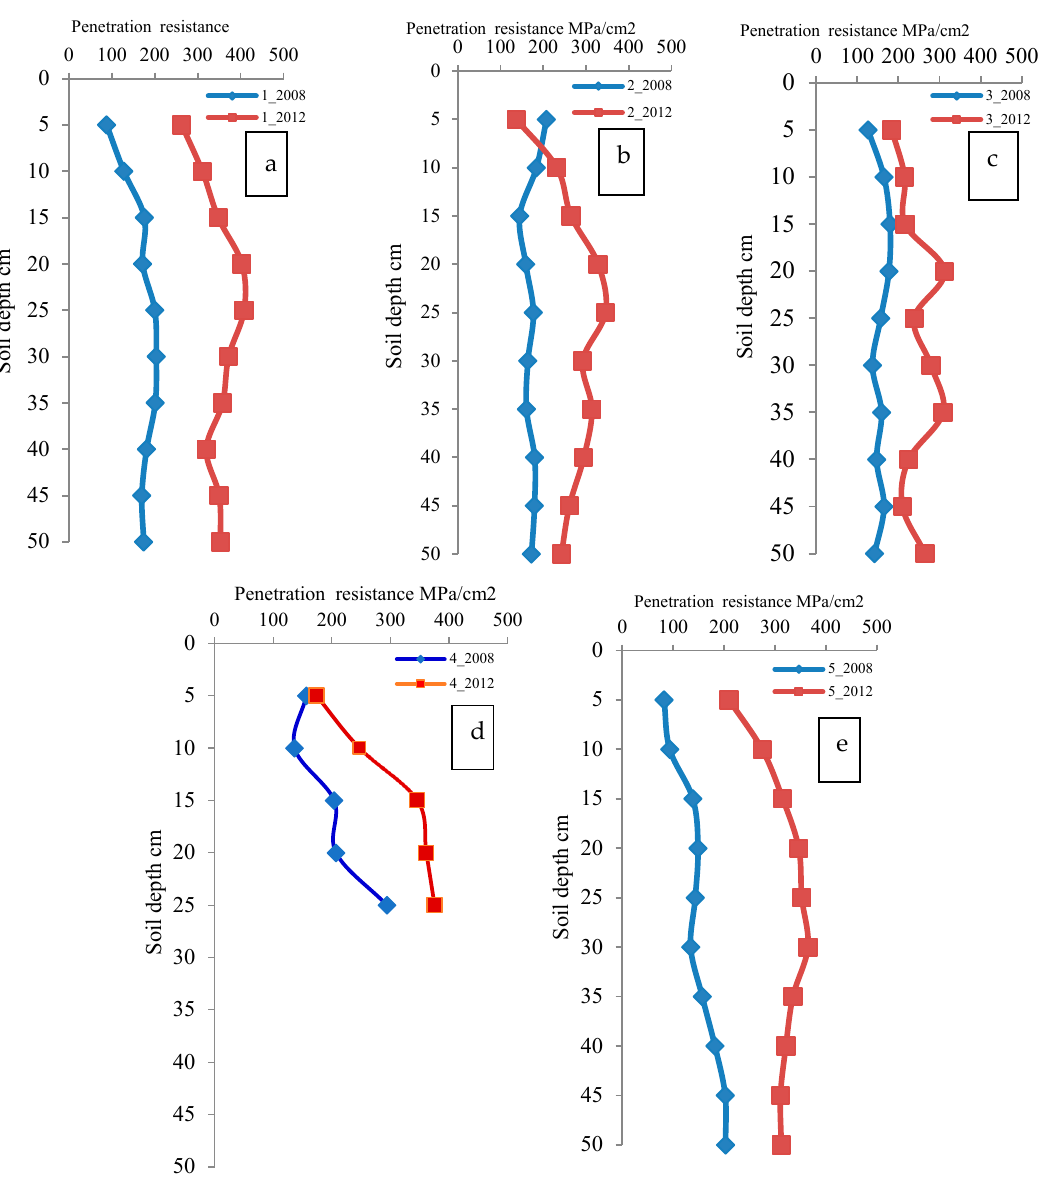
Figure 3. Penetration resistance with soil depth for field locations; a, b c, d, and e under organic farming in 2008 and 2012.